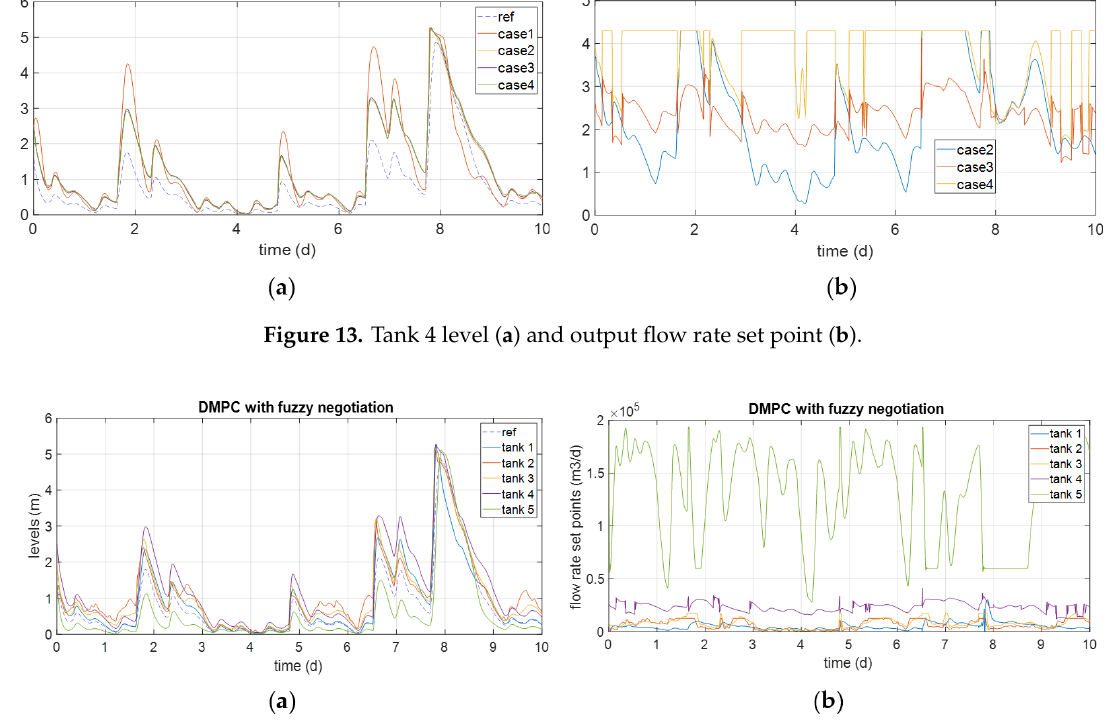
Figure 14. Case 3 levels ( a ) and output flow rate set points (DMPC) ( b ).